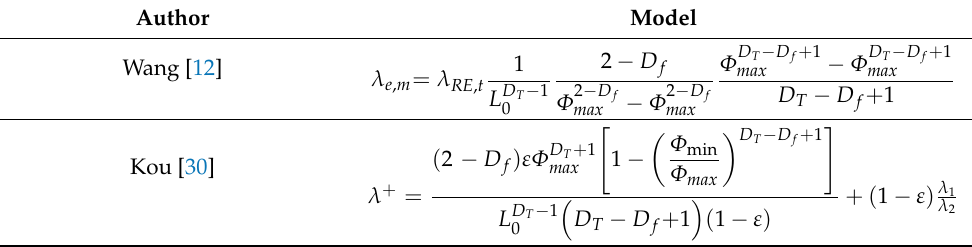
Figure 4. The calculated results are compared with the experimental data of Jing [28] and the com- parison of calculation results of different ETC models.